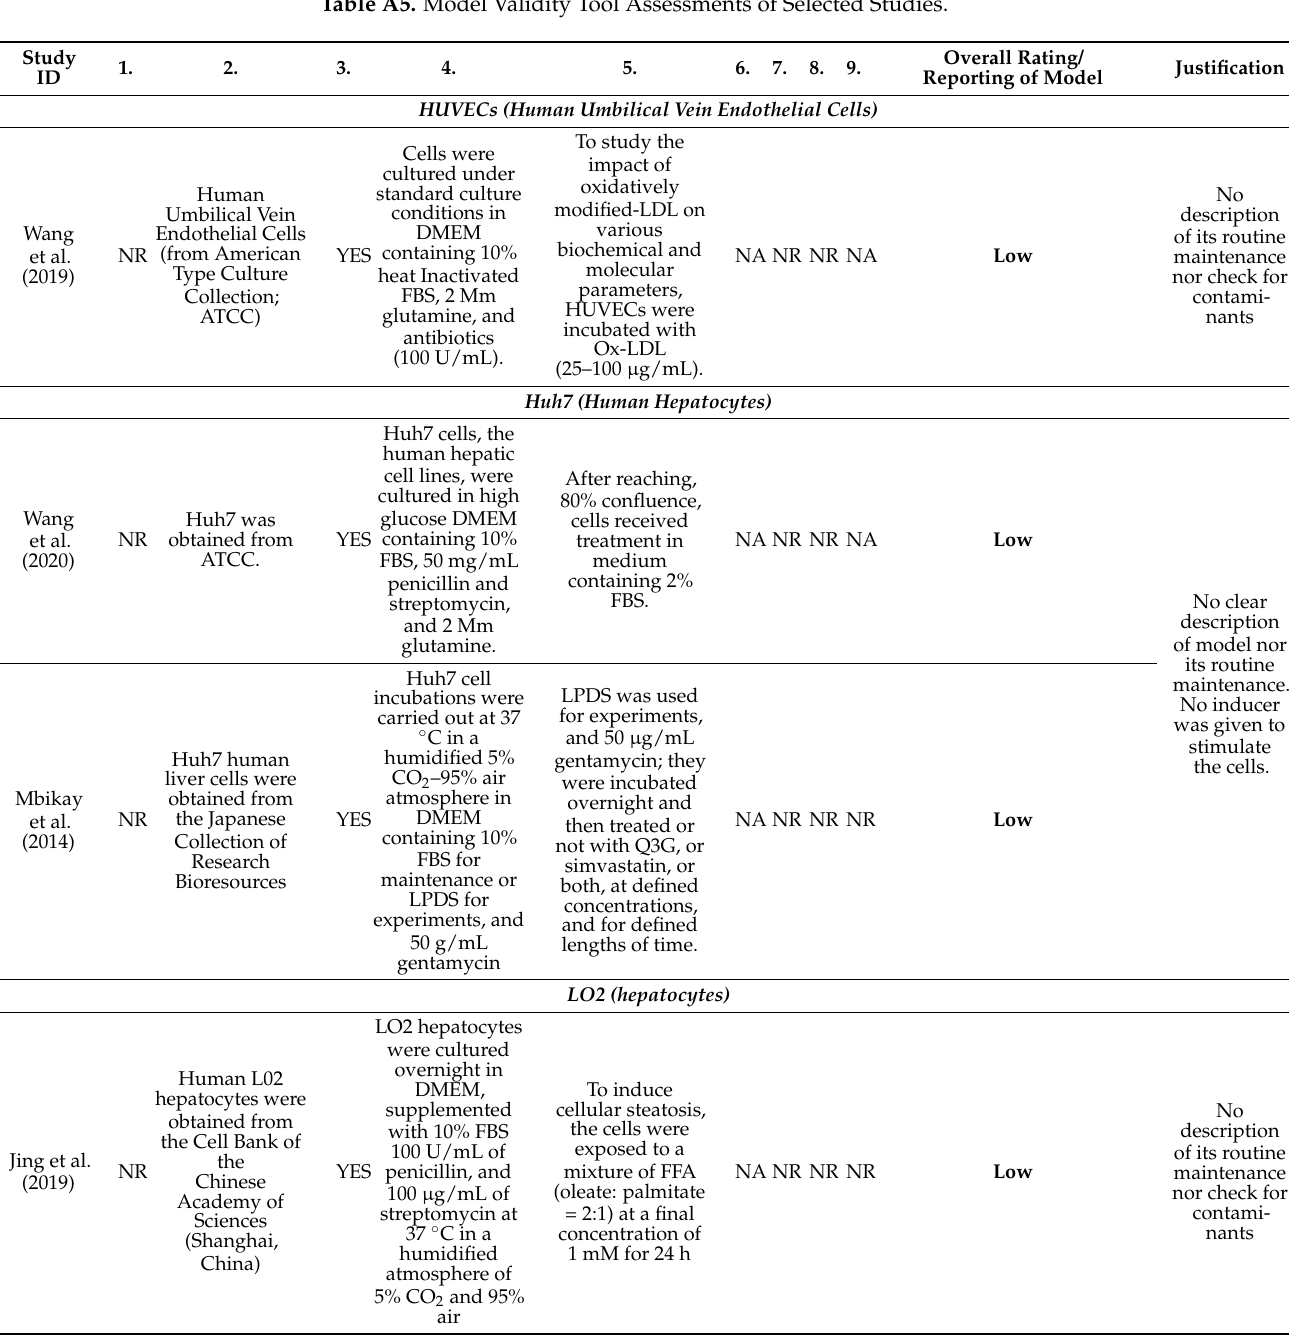
Table A5. Model Validity Tool Assessments of Selected